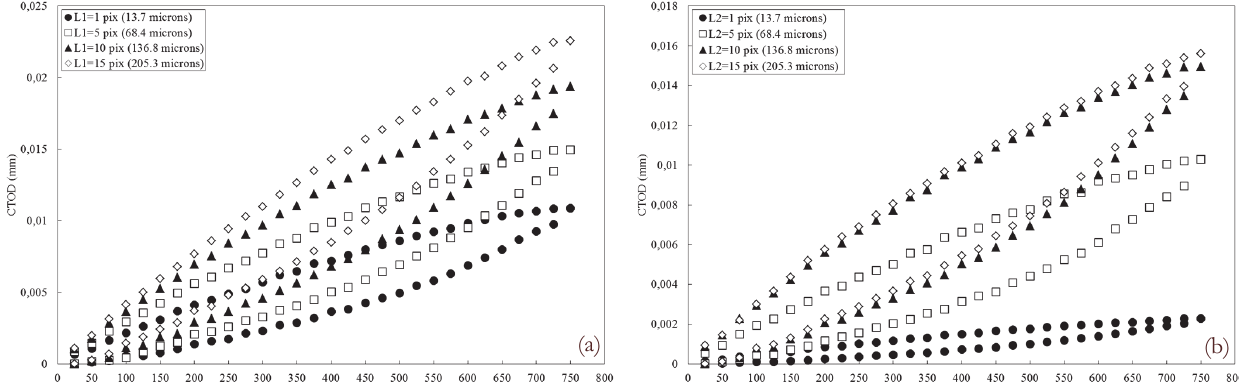
Figure 6: Plots of CTOD versus load along a full loading cycle: (a) for different L 1 values employing a value of 10 pixels (136.8 μ m) for L 2 and (b) for different L 2 values employing a value for L 1 of 5 pixels (68.4 μ m). Thus, L 2 distance used to measure the CTOD will be 10 pixels (136.8 μ m). However, the selection of the L 1 distance